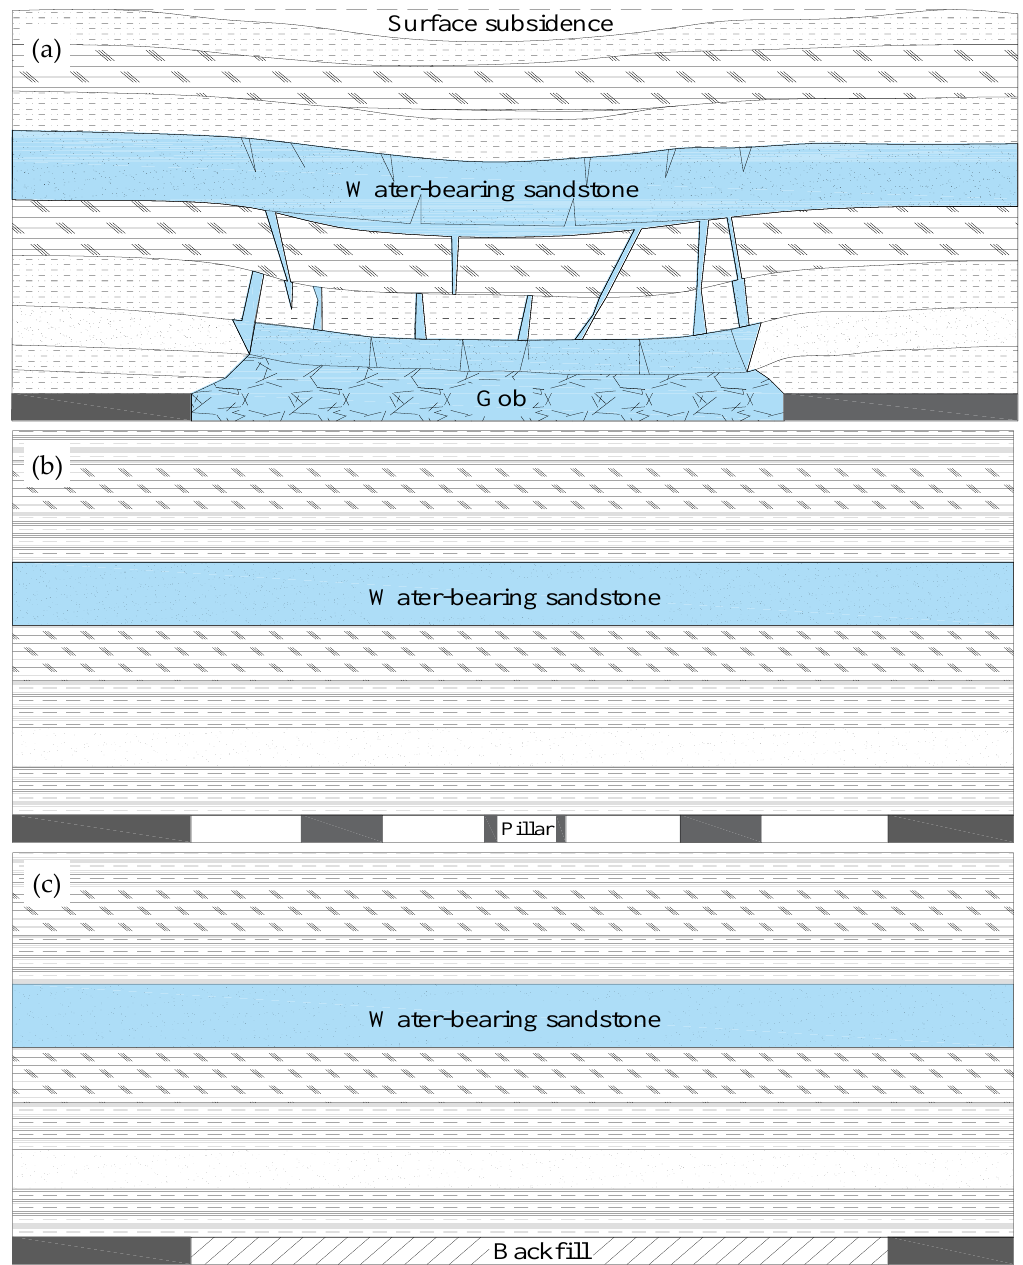
Figure 2. Overburden strata movement with different underground mining methods: ( a ) natural caving method; ( b ) partial mining method; ( c ) backfill mining method.